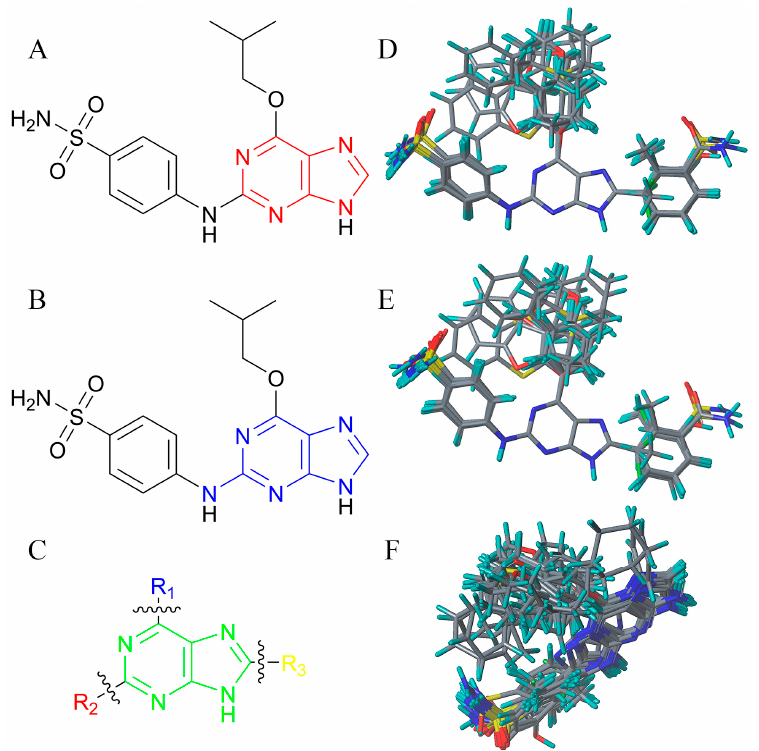
Figure 9. The template of alignment and graph of molecular alignment. ( A ) The common core used in alignment 1. ( B ) The MCS used in alignment 2. ( C ) The R-groups fragmentation scheme. ( D ) Aligned molecules based on alignment 1. ( E ) Aligned molecules based on alignment 2. ( F ) Aligned molecules based on alignment 3.